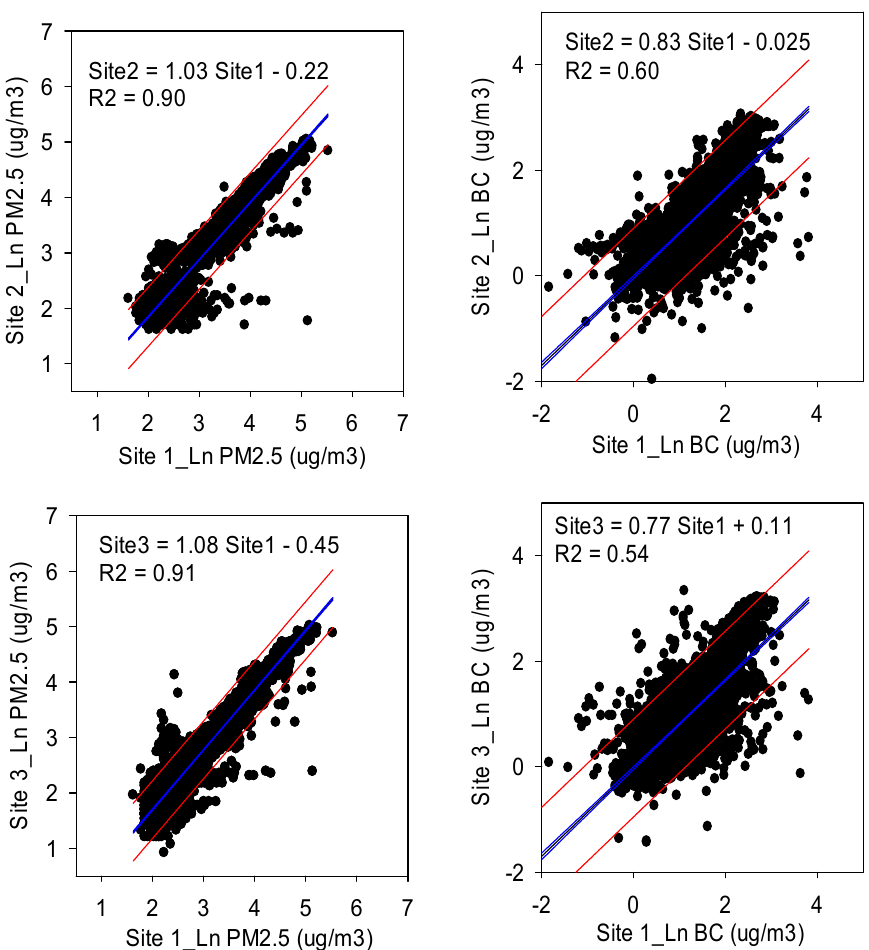
Figure 2. Spatial associations of time matched PM 2.5 ( Left ) or BC ( Right ) concentrations among sampling sites.